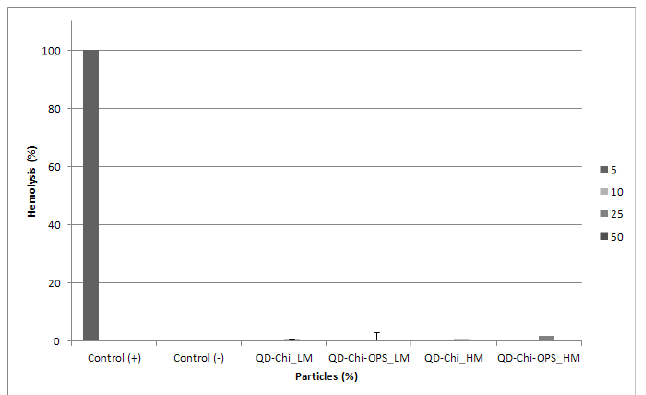
Figure 13. Hemolytic activity of different QD conjugated nanoparticles on human red blood cells. PBS—negative control and 0.2% Triton X-100—positive control.